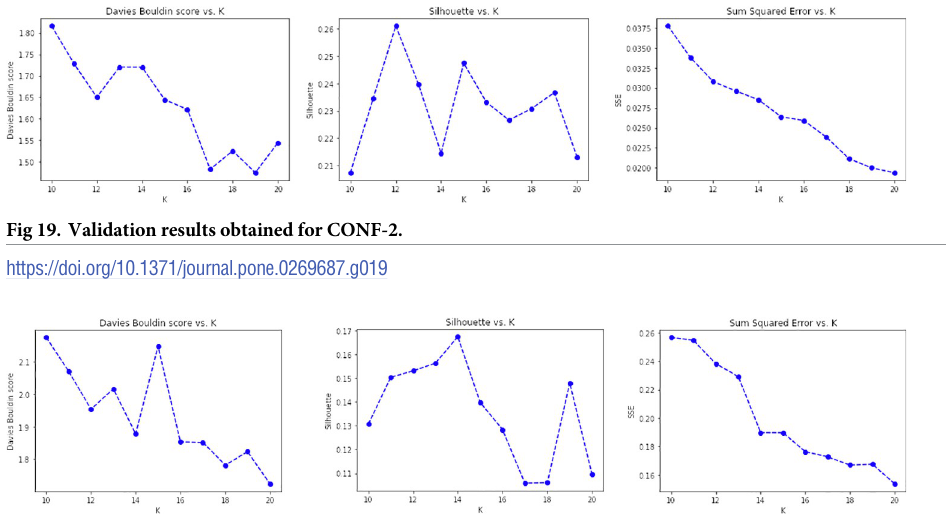
els have been trained resorting to the scikit learn library (https://scikit-learn.org/stable/